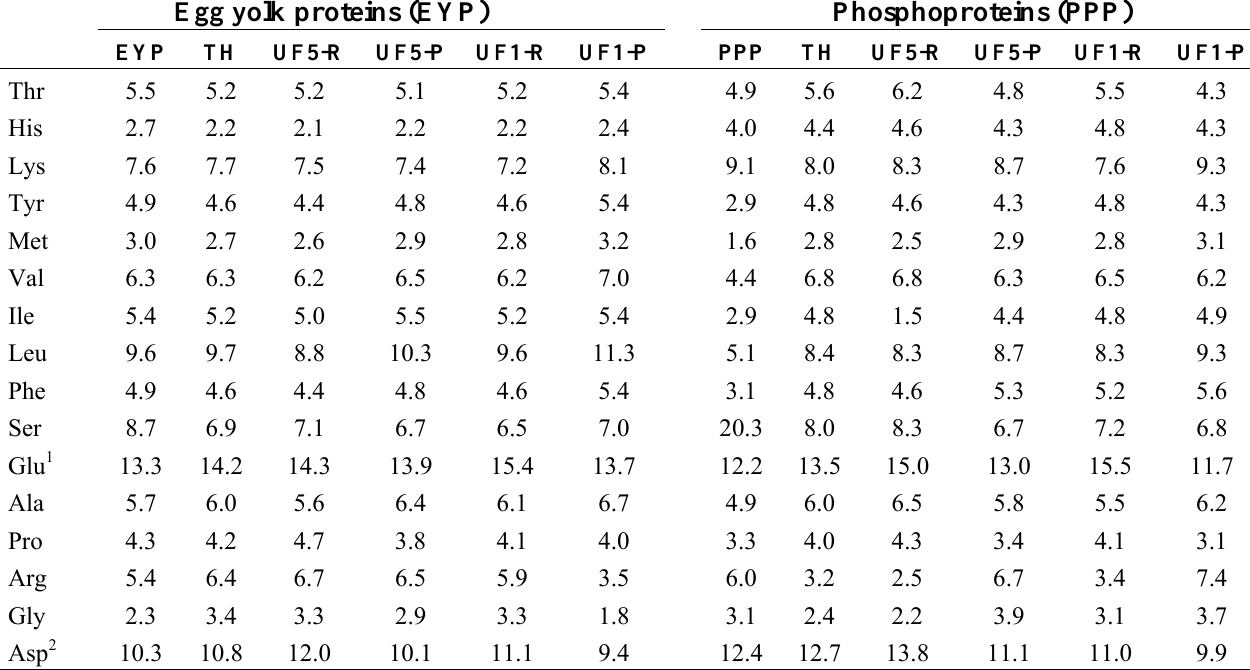
Table 3. Amino acid composition (% of total amino acids, protein basis) of egg yolk proteins (EYP) and phosphoproteins (PPP), their hydrolysates and UF-fractions. Egg yolk proteins